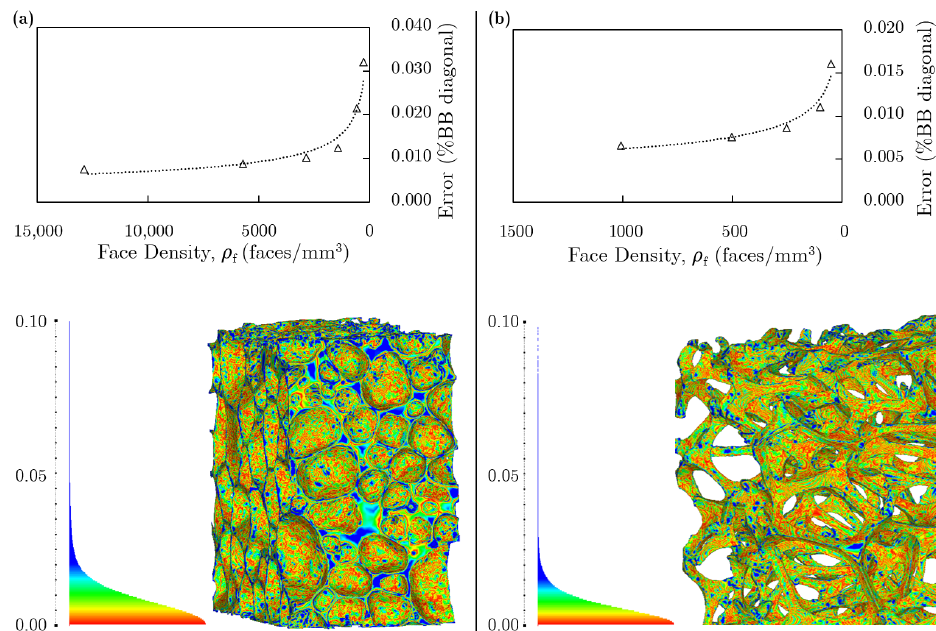
Figure 11. Average of the two-sided Hausdorff distance and visual representation of the Hausdorff distance ( a ) of the cut closed-cell foam specimen and model with 500 thousand faces, i.e., 286 faces per mm 3 and a 99% reduction, ( b ) and of the cubic open-cell foam specimen and model with 500 thousand faces, i.e., 50 faces per mm 3 and a 98%